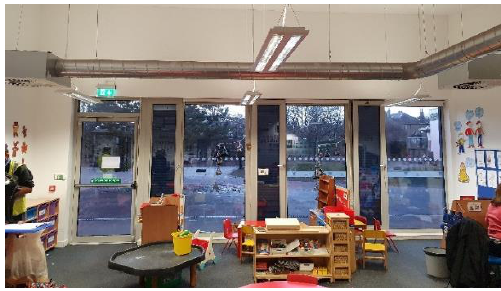
Figure 13. Picture of school D.